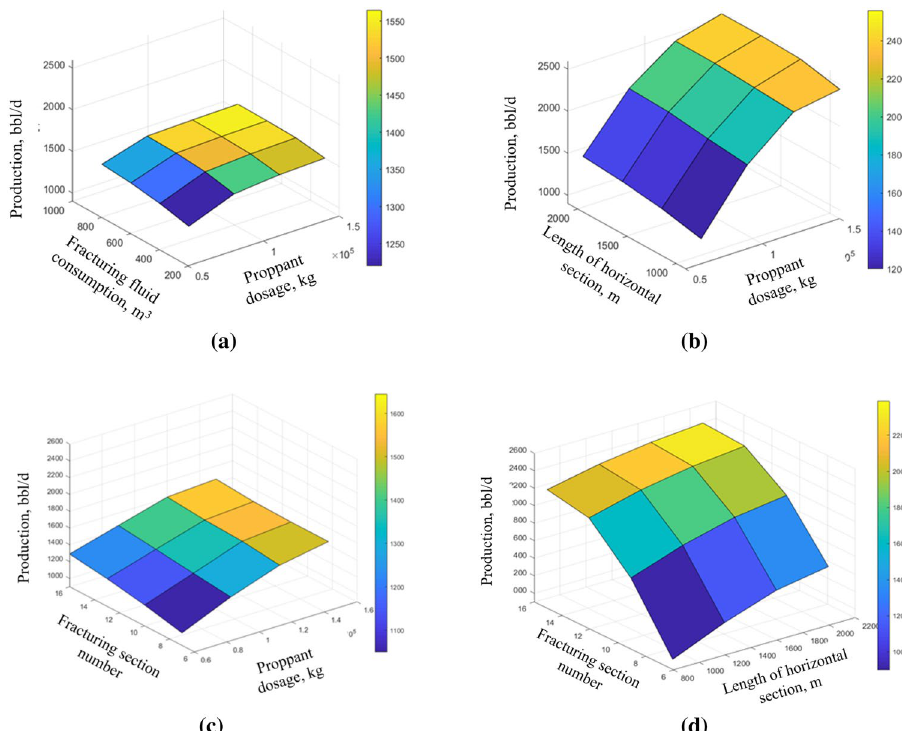
Fig. 23 Production capacity chart under various factors combination